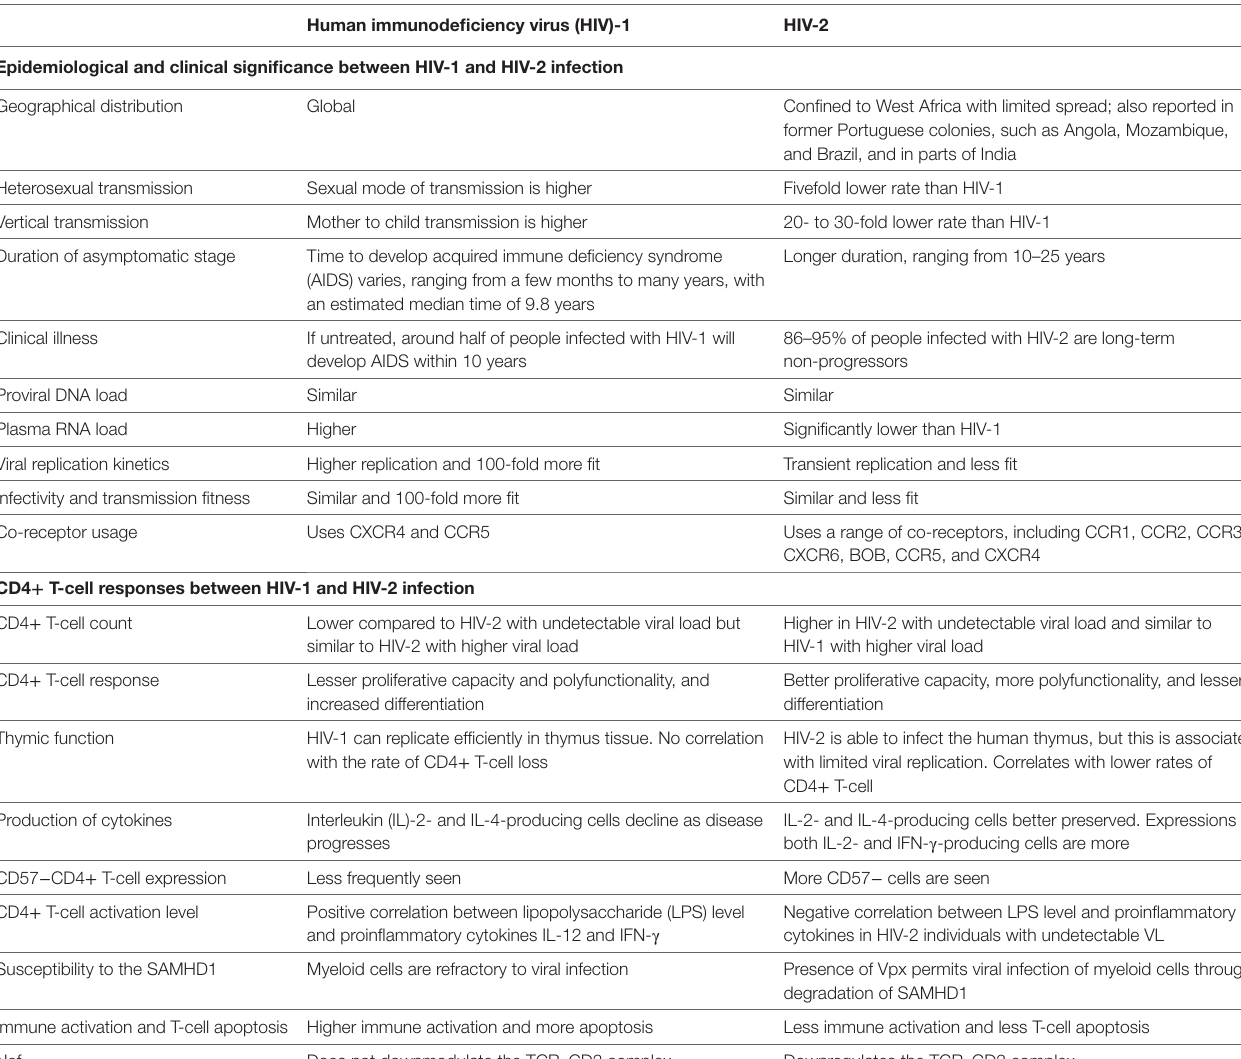
TABLe 1 | Comparison of Hiv-1 and Hiv-2